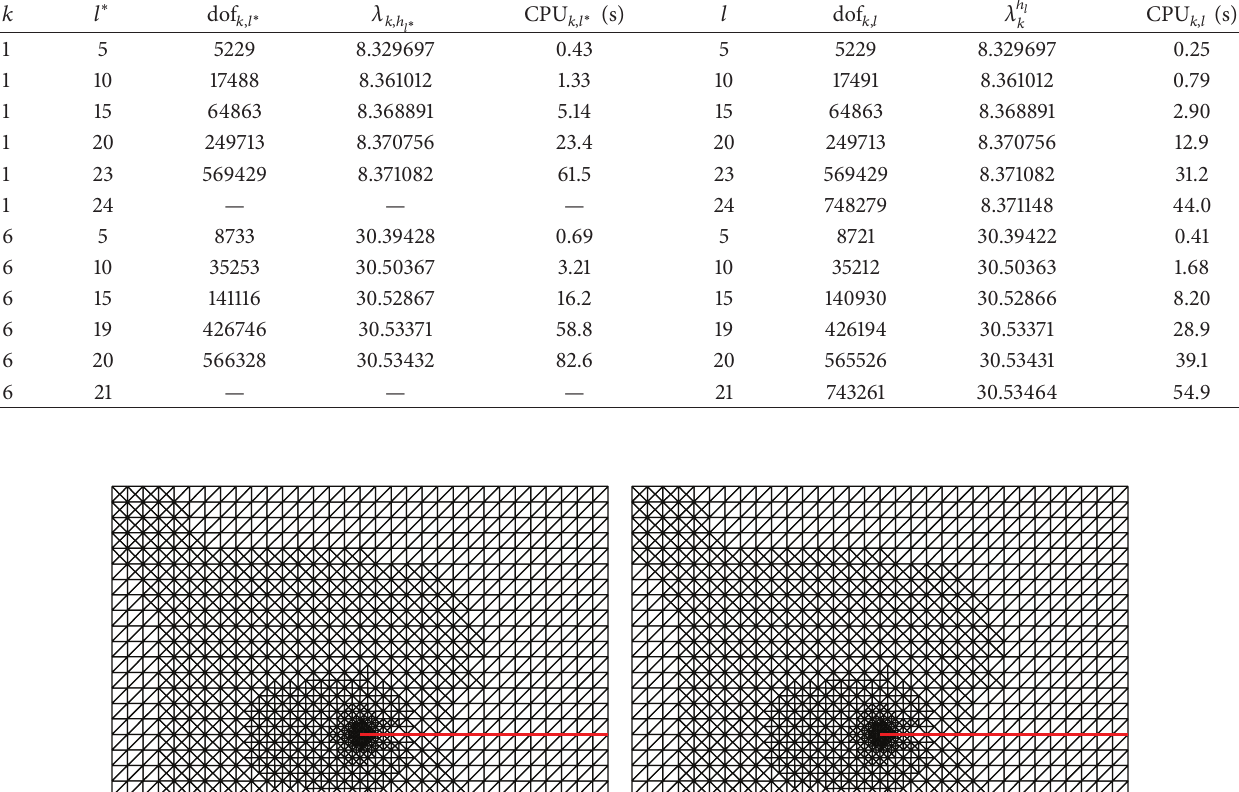
Table 2: The 1st and 6th eigenvalues obtained by two algorithms on slit domain with 𝐻 = √2/16 .